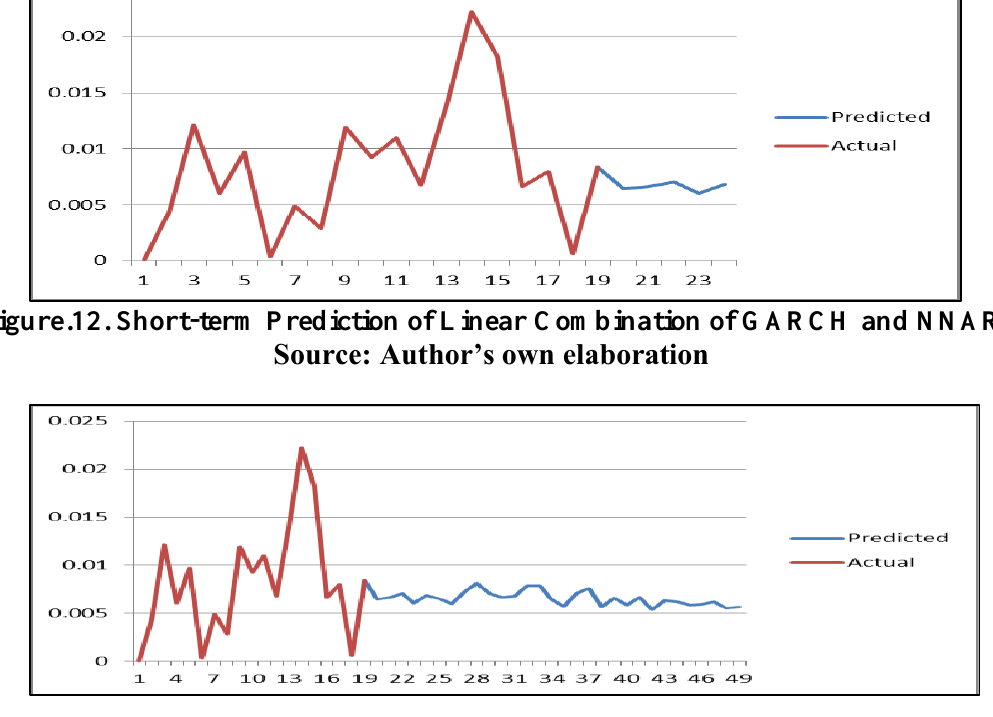
Figure.13. Long-term Prediction of Linear Combination of GARCH and NNAR Source: Author’s own